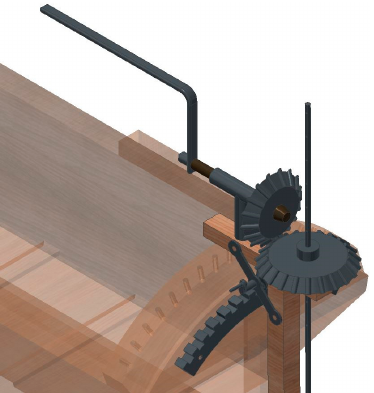
Figure 10 . Details of the crank mechanism with the two tapered gears.